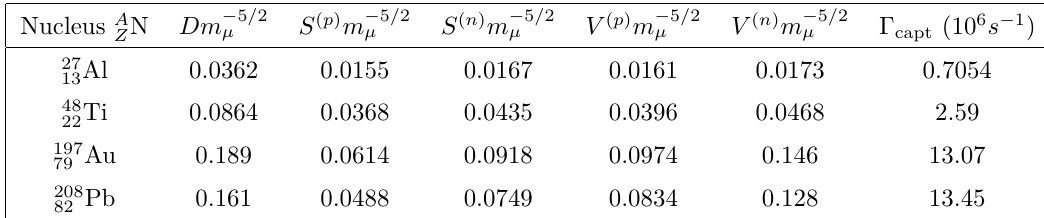
Table 10 . Nuclear form factors and muon capture rate for the µ − e conversion process [168].